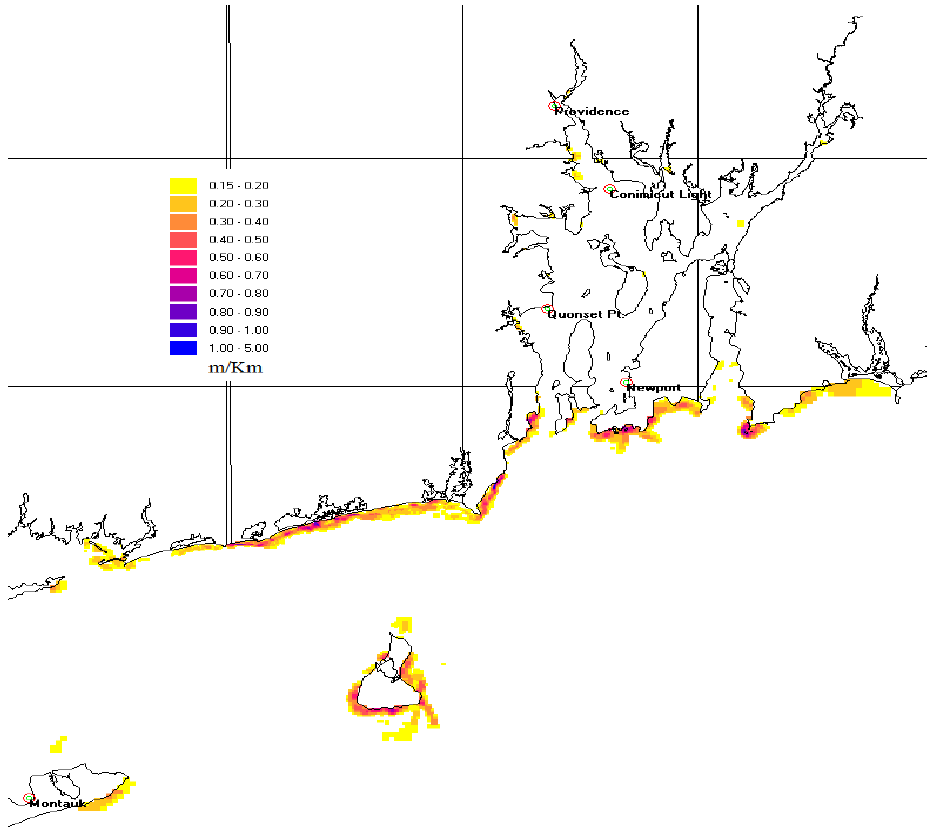
Figure 5. Contour map of the slope of water level (m/km) for NACCS 100 year, upper 95% surge plus tide case.